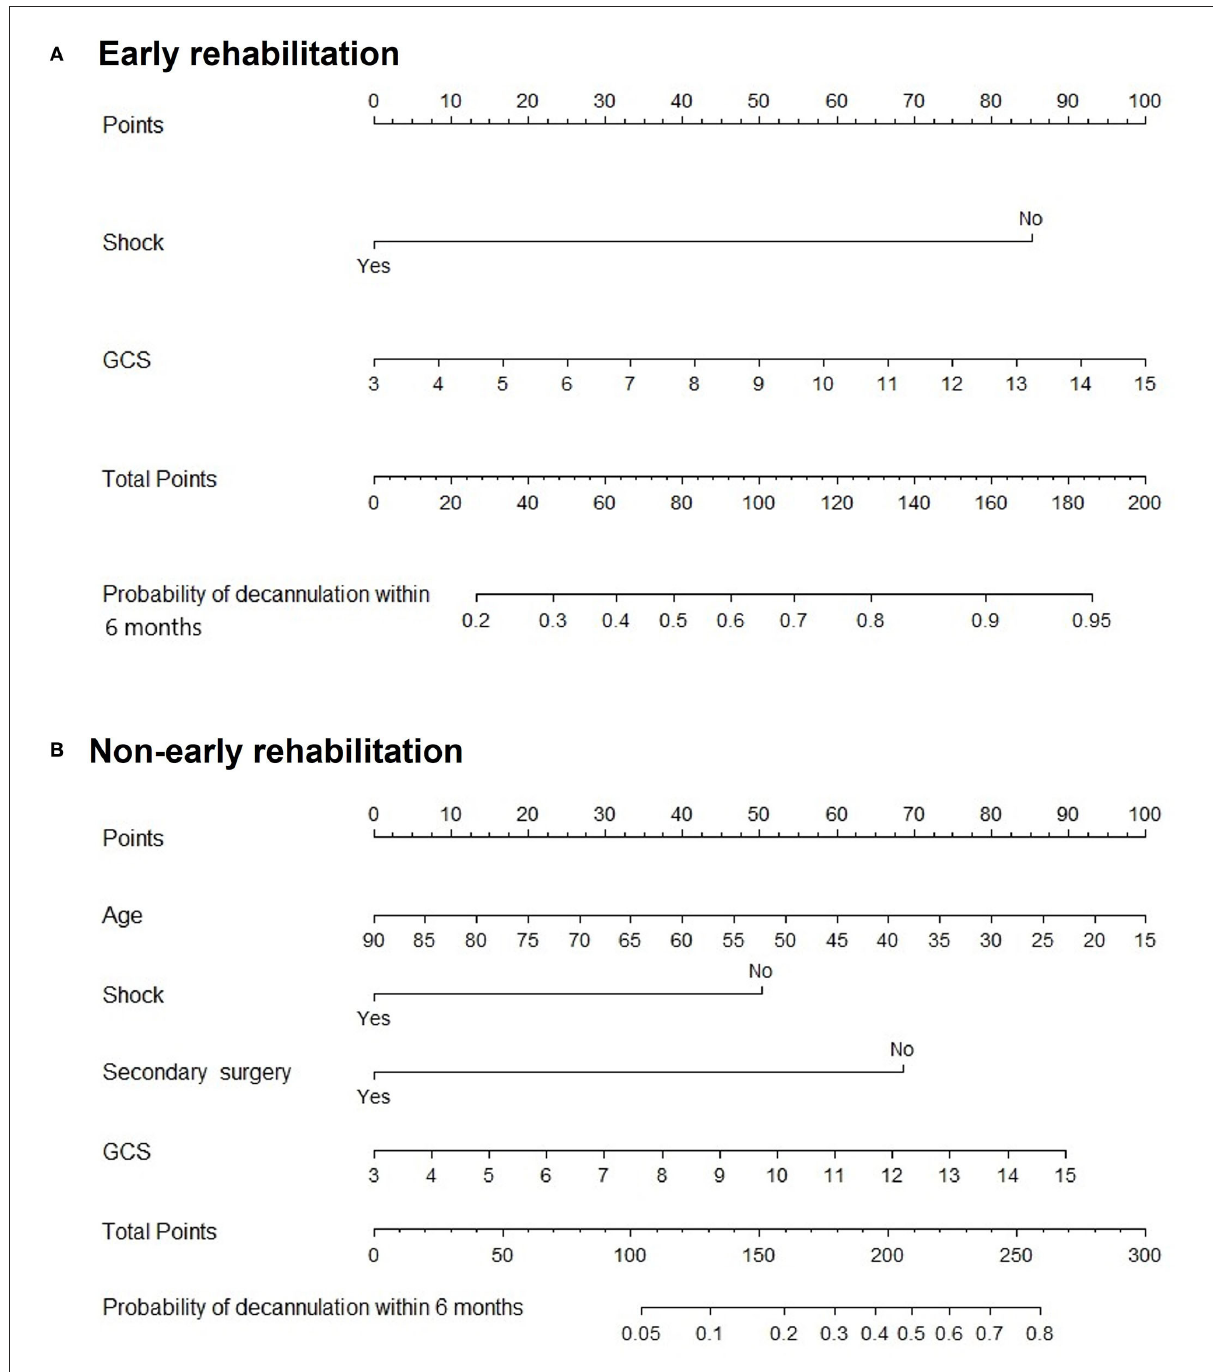
FIGURE6 Nomogram for predicting 6-month decannulation probability in subgroup stratified by early rehabilitation. (A) Patients who received early rehabilitation. (B) Patients who not received early rehabilitation.